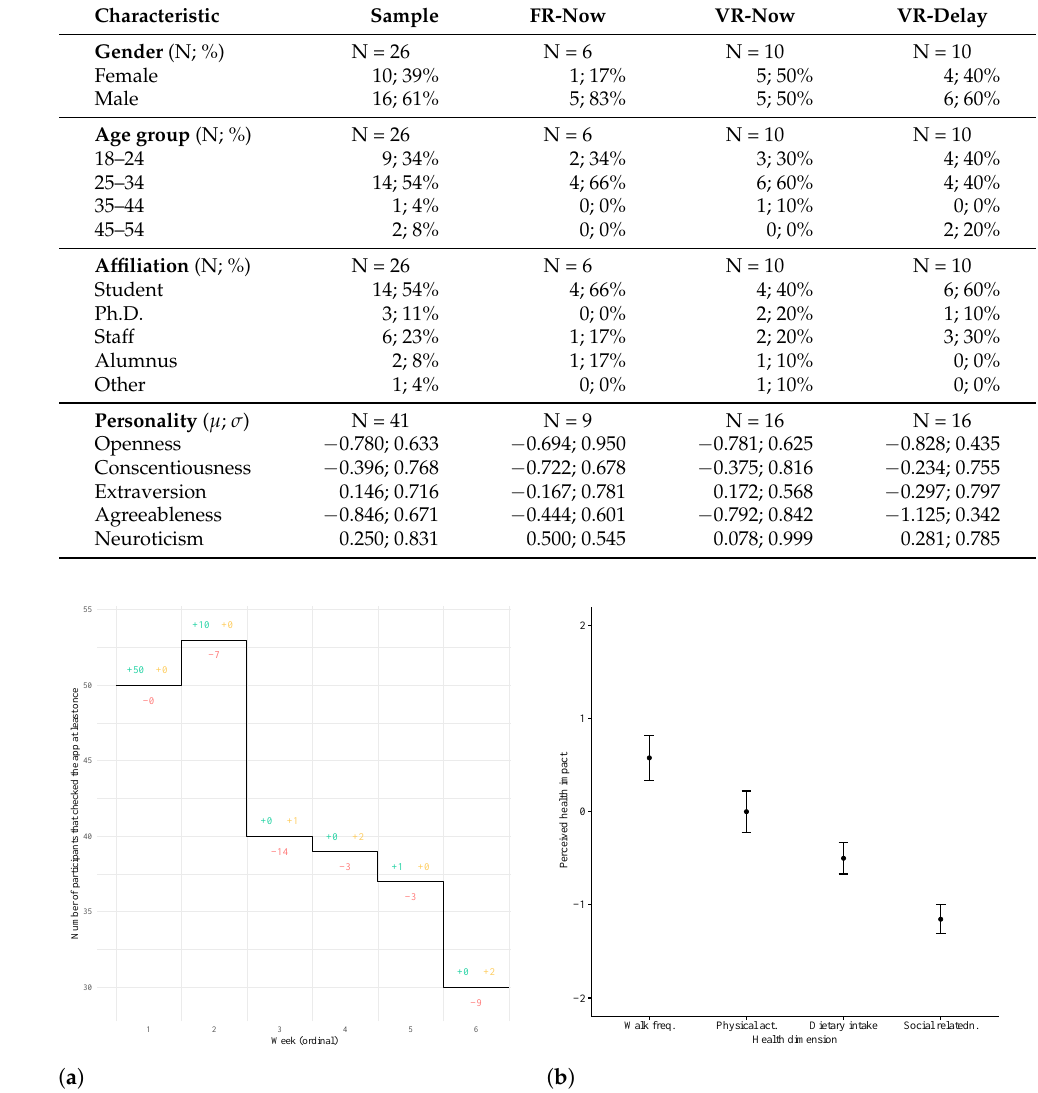
Figure 4. Overview of dropout rates and health impact: ( a ) displays the number of subjects that visited the app at least once, per week, among all participants, N = 61), and ( b ) displays a mean plot of perceived health impact among post-tested participants, N =